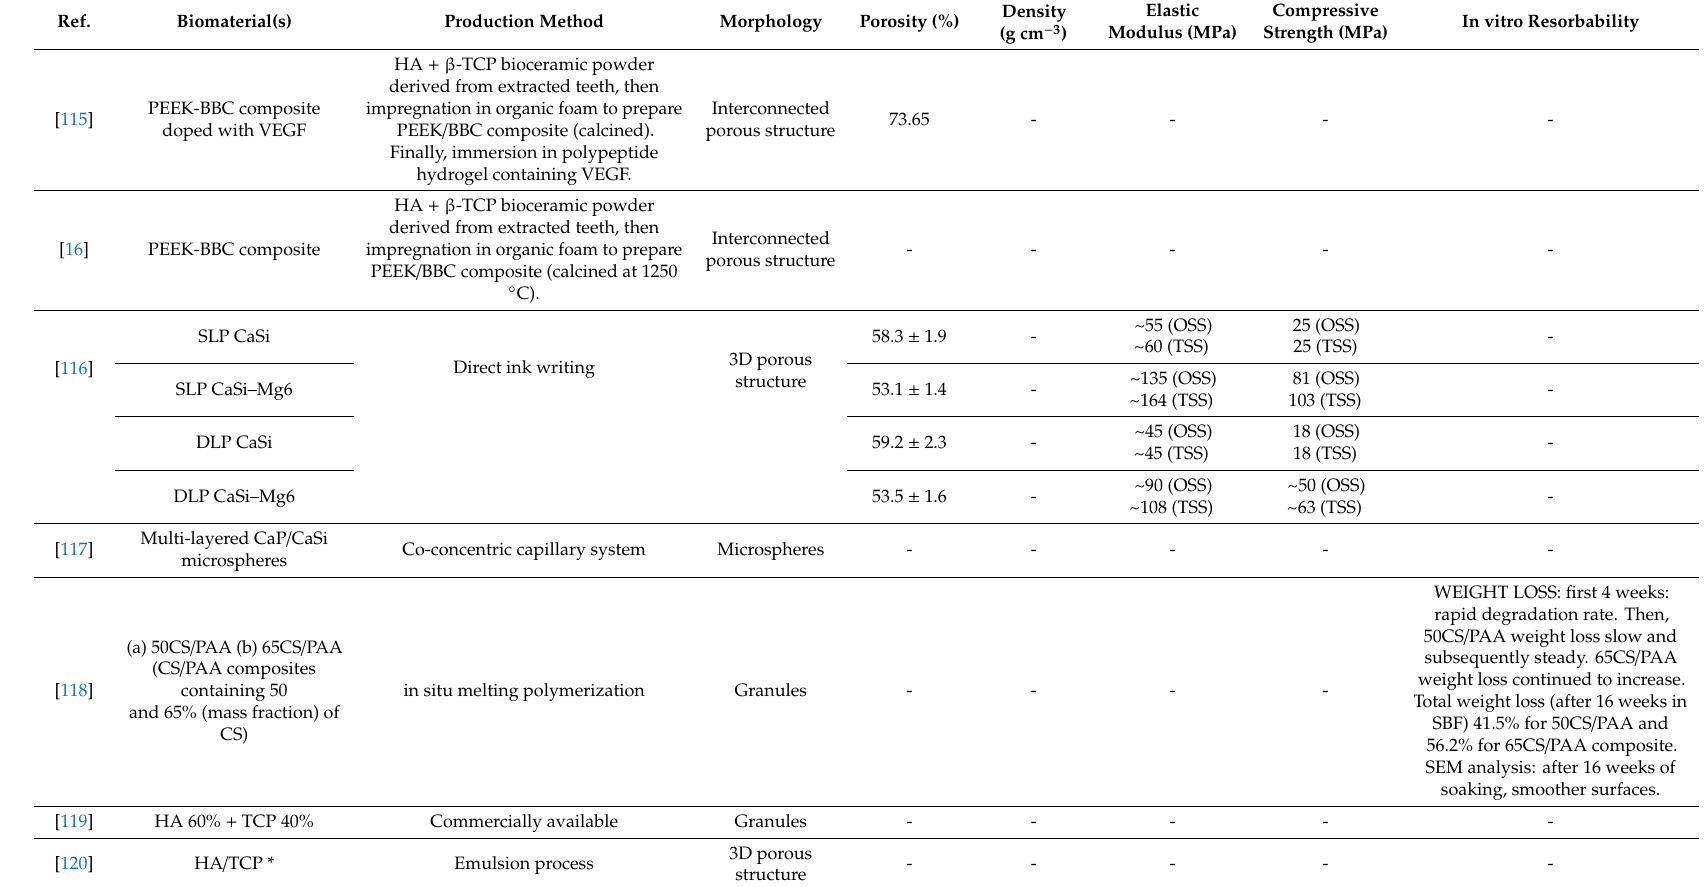
Table 4. Bone sca ff old production method and main